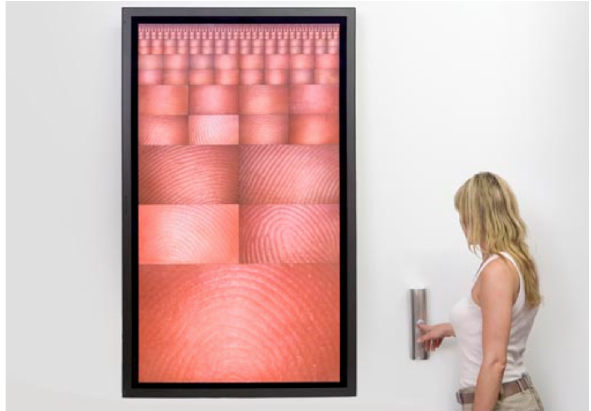
Figure 8 | Rafael Lozano-Hemmer, Pulse Index , 2010. Photo by Antimodular